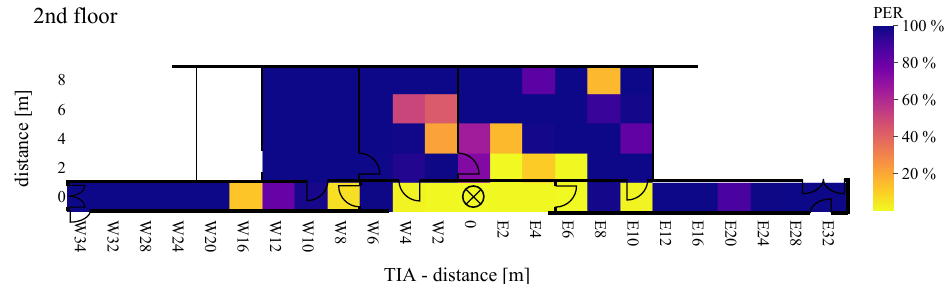
Figure 22. Packet error rate of TIA board with WuRx and WuTx on the same floor.